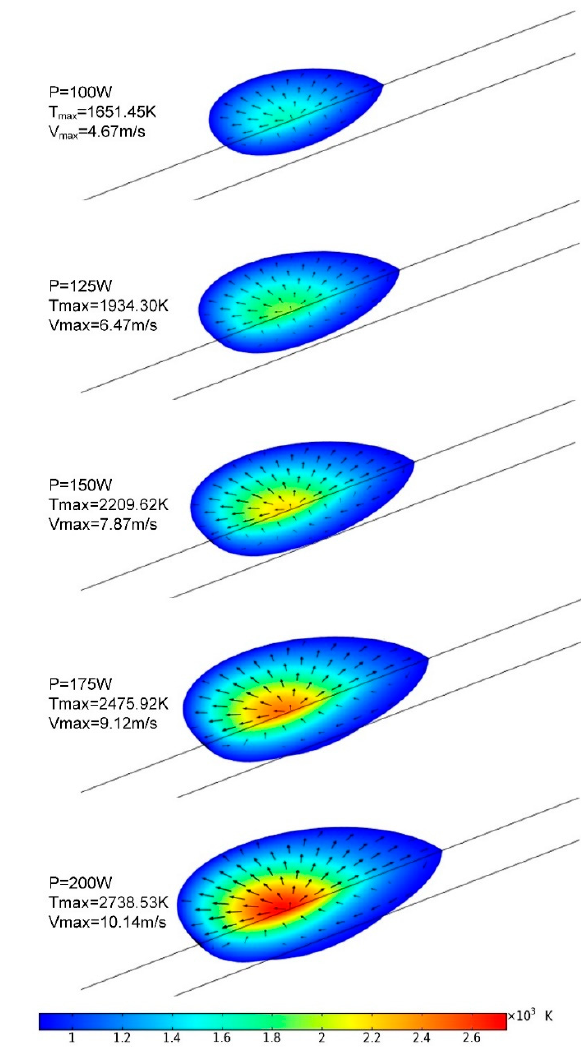
Figure 7. Melt-pool comparison for different laser power levels ( t = 300 μ s).